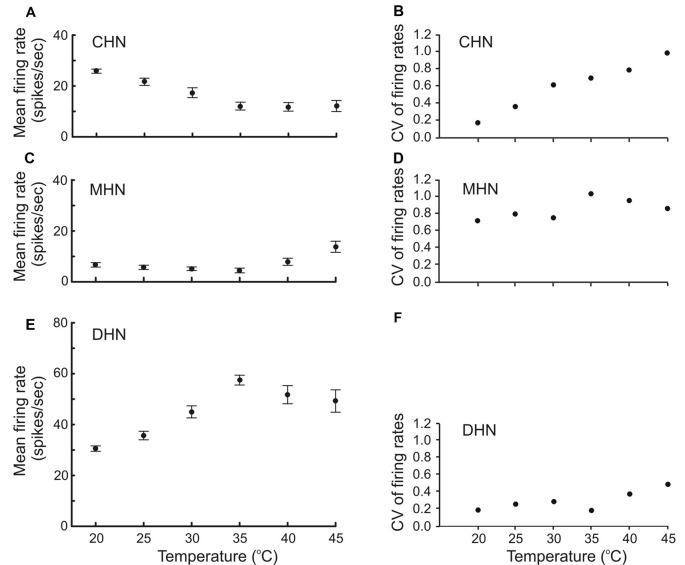
Firing rate response of antennal DSS neurons to different levels of steady temperature (A,C,E) accompanied by their coefficent of variation (B,D,F). Both regular spike trains and bursty spike trains of the neurons combined were subjected to the analysis. Recordings were made at constant absolute humidity 9 g m–3 condition. Note that mean firing rate of the CHN and DHN did not depend on temperature at the high end of noxious heat ranging from 35 to 45°C (A,E). Also note that response variation of the CHN in different DSS increases with temperature increase (B).Vertical bars show standard errors of the means. CV, coefficient of variation. The number of tested insects for each data point (N) = 30.